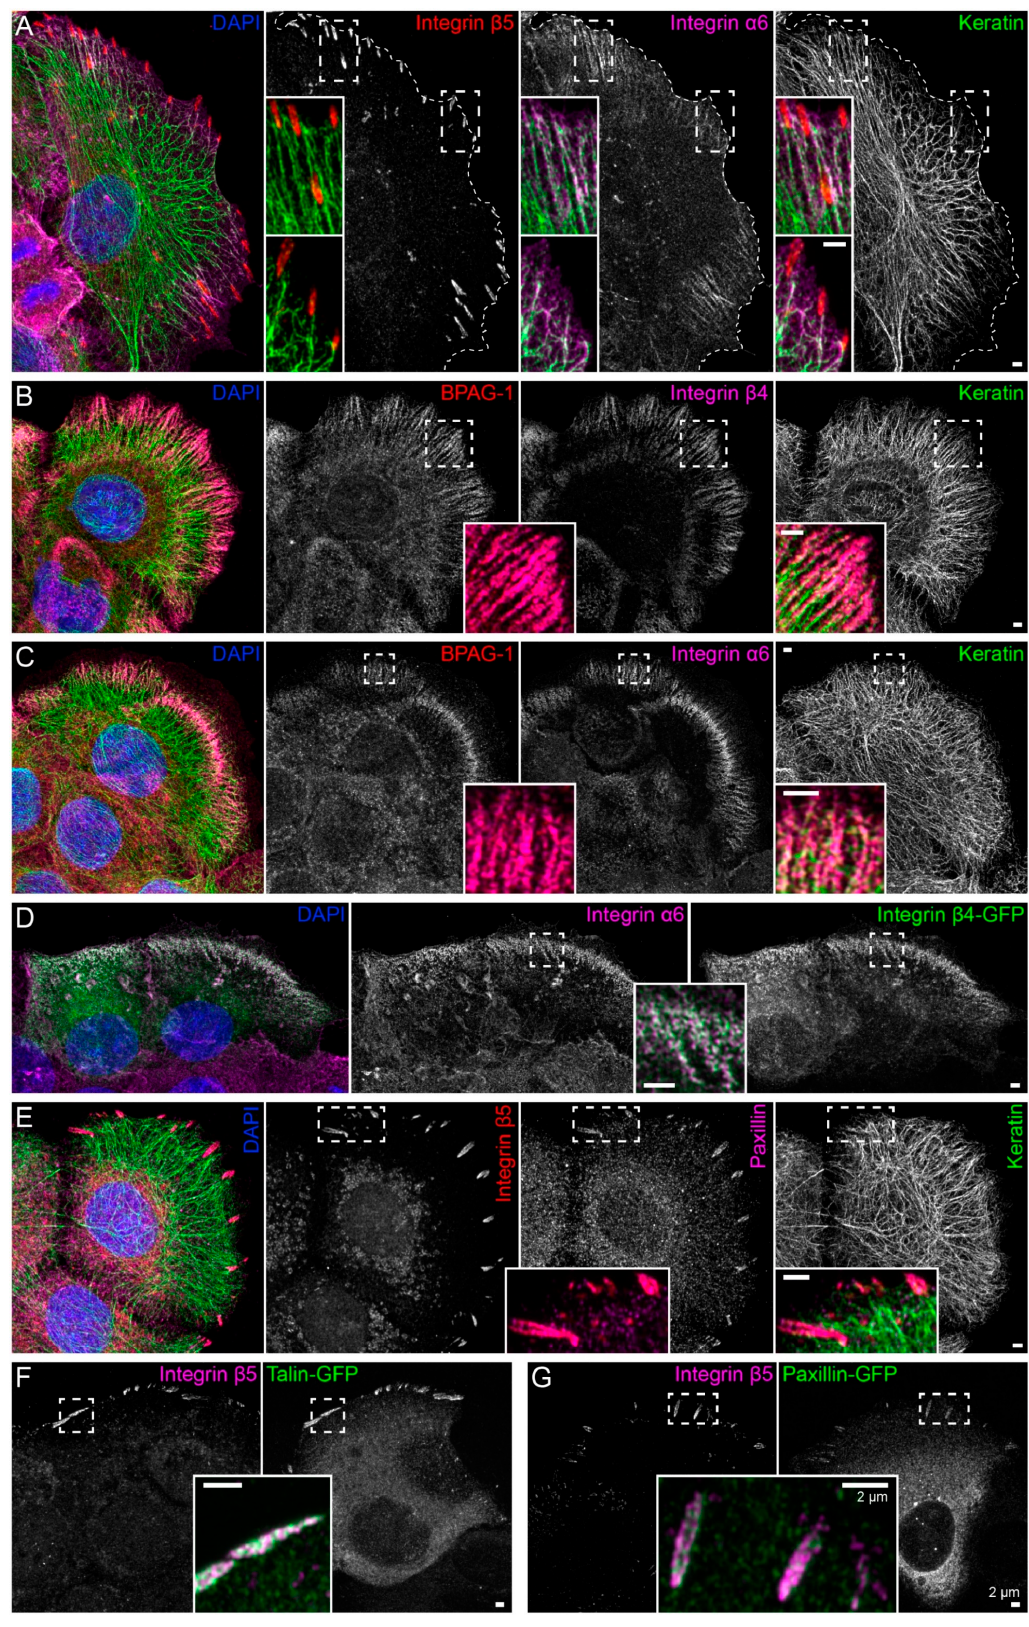
Figure 1. Keratin filaments are connected to hemidesmosomes, many of which are clustered next to focal adhesions. The fluorescence micrographs show antibody staining, nuclear 4 (cid:48) ,6-diamidino-2-phenylindole (DAPI) staining (blue), and